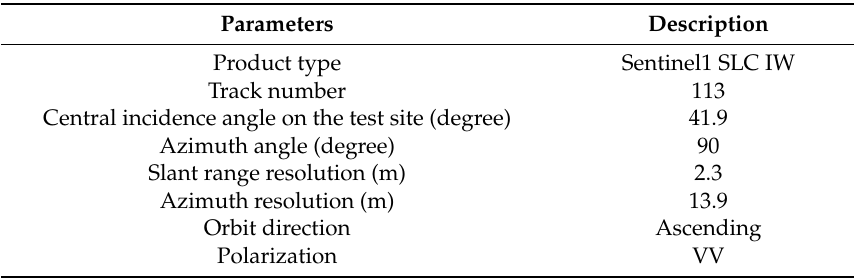
Figure 1. Location of study area and Sentinel-1A TOPS SAR data coverage: ( a ) the study area is outlined by a red rectangle; and ( b ) a SAR mean intensity image of Sentinel-1A covering the study area. Table 1. Specific parameters of Sentinel-1A TOPS data.